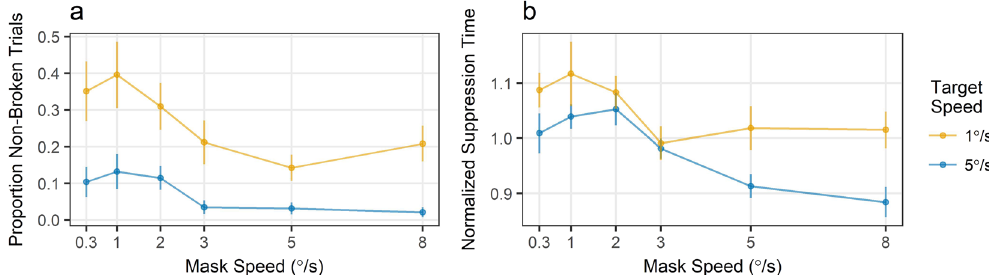
Figure 3. The relationship between the target and mask speeds and the suppression strength in Experiment 2. ( a ) Proportion of no-response trials. The faster targets were more consistently detected. ( b ) Faster targets were also detected faster. Matching the mask speed to that of the target did not lead to most effective suppression: the optimal mask speed was approximately the same (1–2°/s) for both target speeds. Dots are group means with error bars reflecting standard